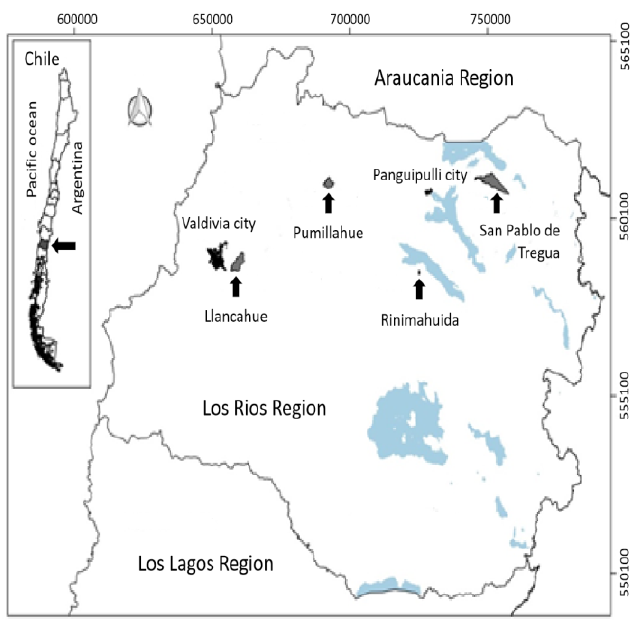
Figure 1. Study sites location in the landscape of south-central Chile: Llancahue, Pumilahue, Rinimahuida, and San Pablo de Tregua. Blue areas are major lakes.